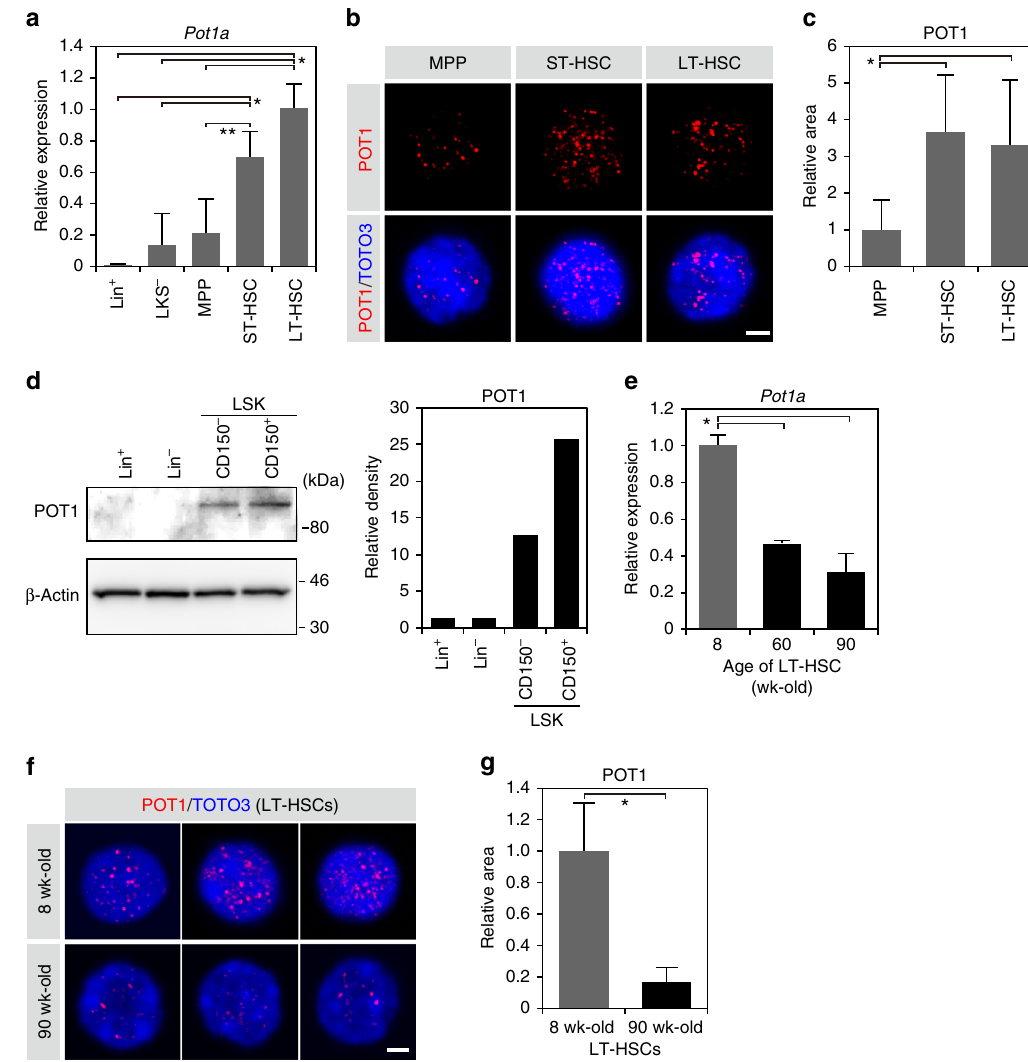
Fig. 1 Expression of Pot1a in HSPCs. a Expression of Pot1a in: Lineage + (Lin + ) cells; Lin − Kit + Sca-1 − (LKS − ) cells; LSKCD41 + CD48 + CD150 − multipotent progenitor (MPP) cells; LSKCD41 + CD48 + CD150 + cells (ST-HSCs); LSKCD41 − CD48 − CD150 + cells (LT-HSCs) isolated from 8 week-old mice. Data are expressed as the mean ± SD ( n = 4, * p < 0.01, ** p < 0.05 by Tukey ’ s test). Representative data from two independent experiments are shown. b Immunocytochemical staining of POT1 (red) in HSPCs. Nucleus is stained by TOTO3 (blue). Scale bar, 2 μ m. c Relative area of POT1 immuno fl uorescent dots in HSPCs. Fluorescence images were analyzed with ImageJ. Data are expressed as the mean ± SD ( n = 64: MPP, n = 67: ST-HSCs, n = 54: LT-HSCs, * p < 0.01 by Tukey ’ s test). Representative data from two independent experiments are shown. d Immunoblot analysis of POT1 in Lin + , Lin – , LSKCD150 – , and LSKCD150 + cells (left panel). Densitometry analysis of the immunoblot is shown in the right panel . Representative data from two independent experiments are shown. e Expression of Pot1a in 8, 60, and 90 week-old LT-HSCs. Data are expressed as the mean ± SD ( n = 4, * p < 0.01 by Tukey ’ s test). Representative data from two independent experiments are shown. f Immunocytochemical staining of POT1 (red) in LT-HSCs isolated from 8 and 90 week-old mice. Scale bar , 2 μ m. g Relative area of POT1 immuno fl uorescent dots in LT-HSCs isolated from 8 and 90 week-old mice. Data are expressed as the mean ± SD ( n = 146: 8-week-old, n = 180: 90-week-old, * p < 0.01 by t